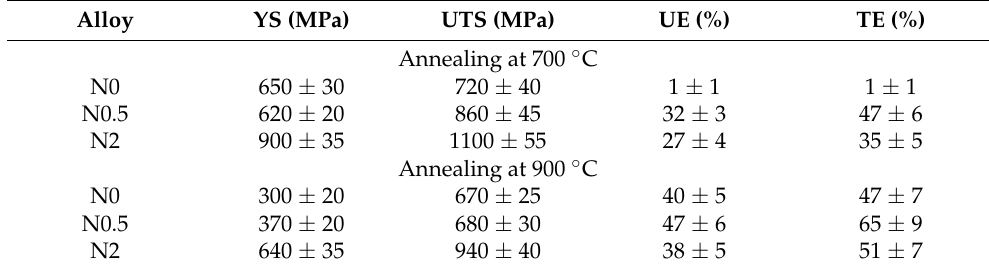
Table 4. Room temperature mechanical properties of the Fe 40-x Mn 40 Cr 10 Co 10 N x alloys after annealing.